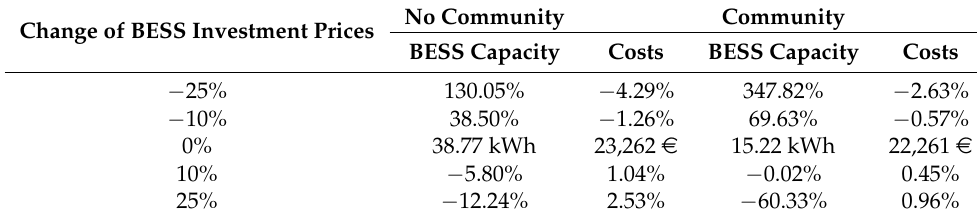
Table 5. Variation of battery energy storage systems (BESS) investment prices from − 25% to + 25% and the effect on installed BESS capacity and the total costs, based on the data of